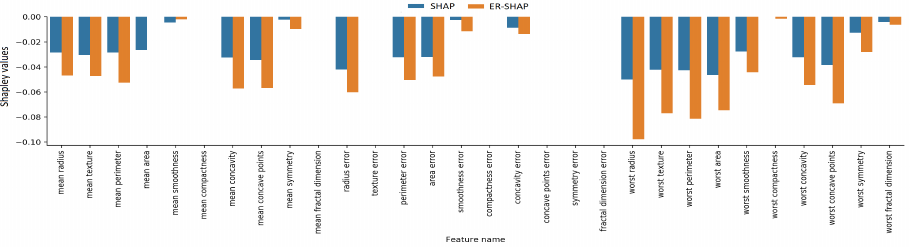
Figure 26. Shapley values obtained by means of SHAP and ERW-SHAP for features of the Breast Cancer dataset under condition of using the normal distribution of feature changes with the standard deviation 0.1.